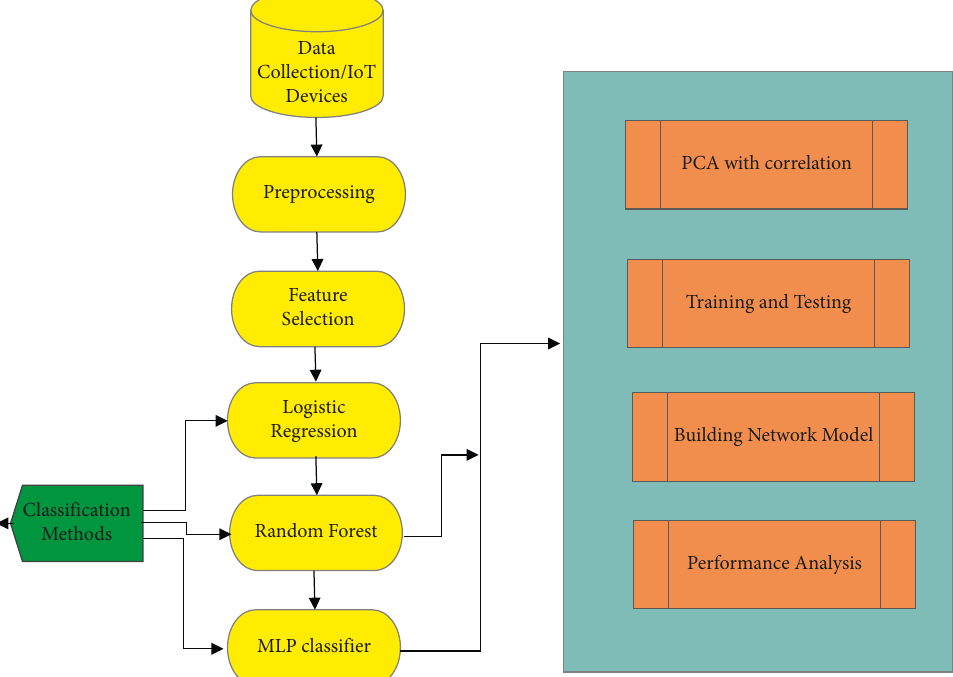
Figure 4: Stages of breast cancer detection using IoT systems [2].